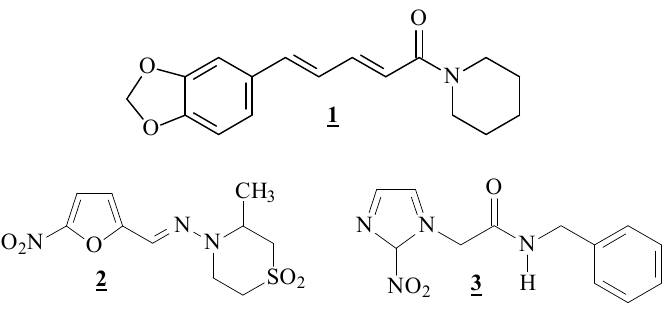
Figure 1. Chemical structures of piperine ( 1 ), nifurtimox ( 2 ) and benznidazole ( 3